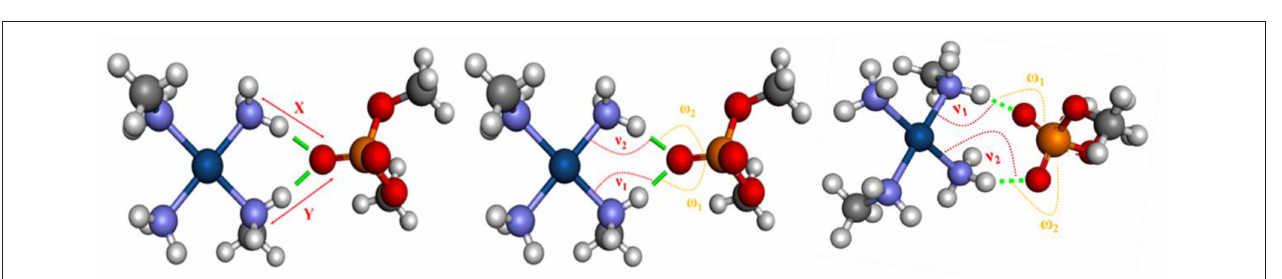
Frontiers in Chemistry |